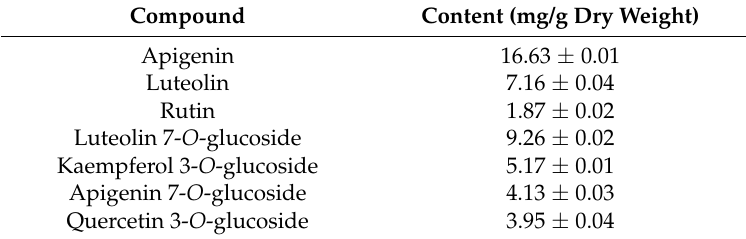
Table 1. Content of major flavonoid compounds in the flower extracts of P. fortunei (EPF) used in the